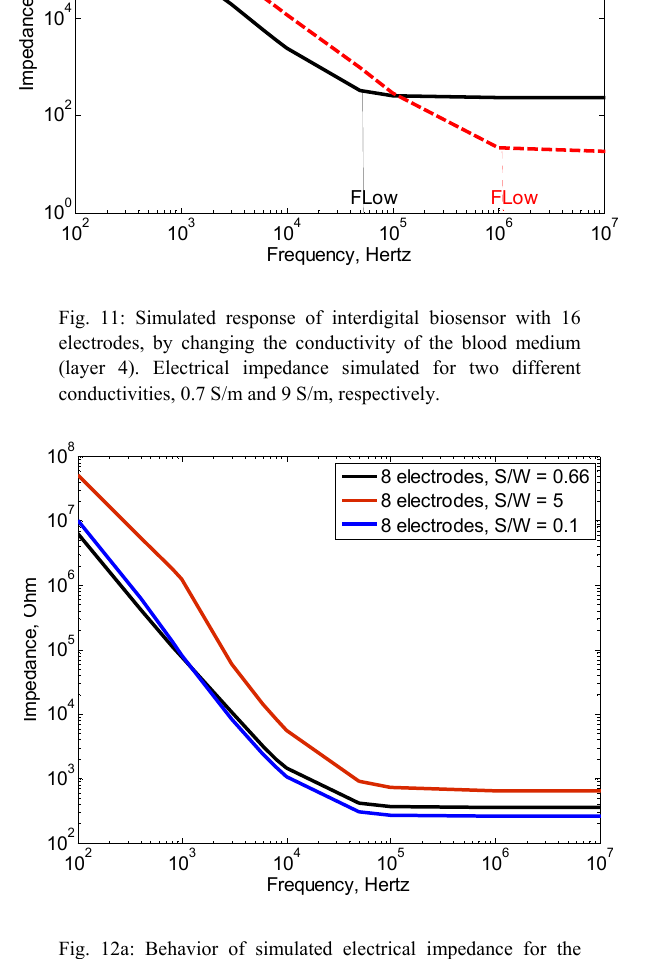
Fig. 12a: Behavior of simulated electrical impedance for the blood medium by varying the cell constant of the sensor with changing the ratio between width of electrodes and gap, while leaving the same contact area of sensor 1000 × 1000 microns by N = 8 electrodes.